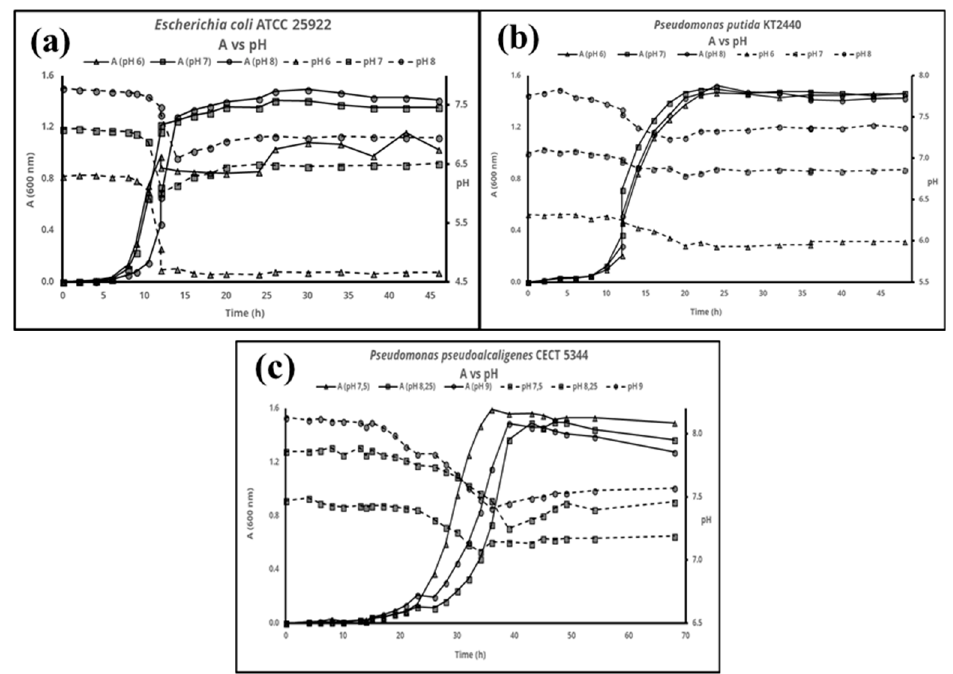
Figure 2. Evolution of the pH during the growth of several strains in M63 media with glucose (4 g/L) as C-source, at different initial pHs. ( a ) E. coli ATCC 25922, ( b ) P. putida KT2440, and ( c ) P. pseudoalcaligenes CECT 5344 were inoculated at the indicated pHs and cell growth (solid lines) an pH of the media (dashed lines) were measured along the experiments, that were run in triplicate. A representative experiment is shown